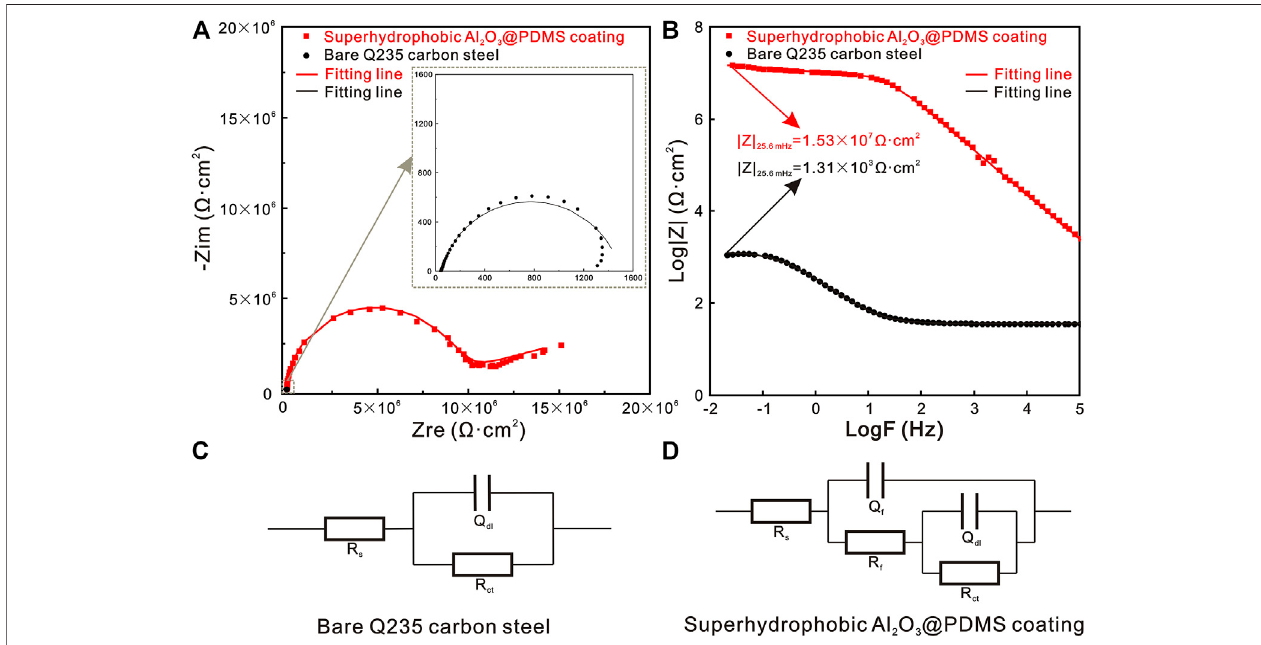
FIGURE5 |(A) Nyquist plots, (B) Bodeplots oflog |Z|vs. logfrequency, and (C,D) equivalent circuit models ofthe bare Q235carbon steel and superhydrophobic